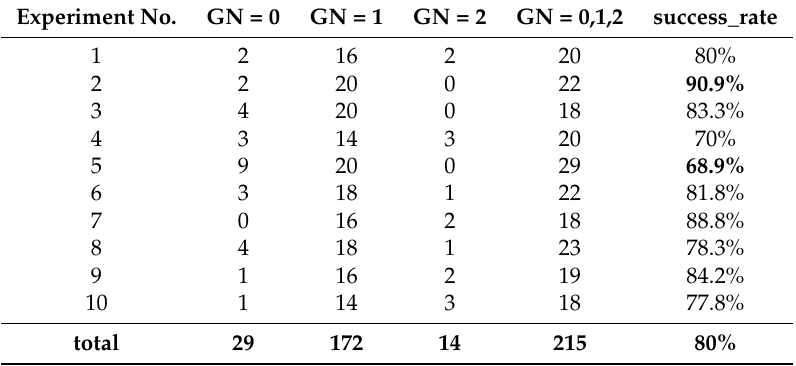
Table 3. Picking the white towels in a laundry basket (GN: the number of towels grasped). Experiment No.